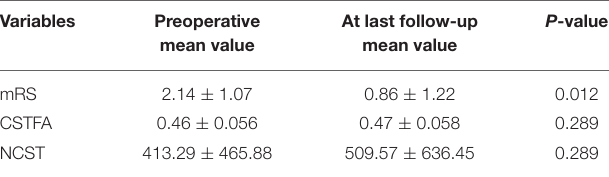
TABLE 2 | Variables associated with long-term motor deficits (Spearman nonparametric test).